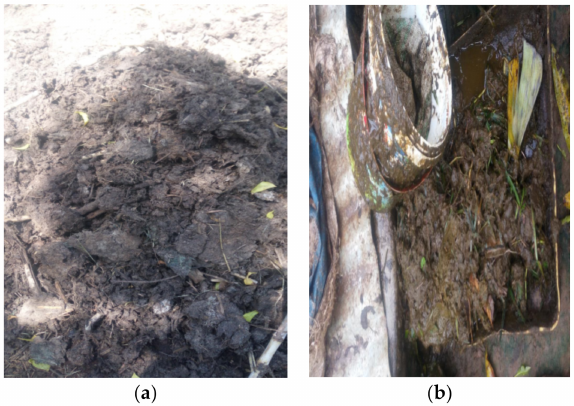
Figure 1. ( a ) Stored cow dung and ( b ) fresh cow dung.